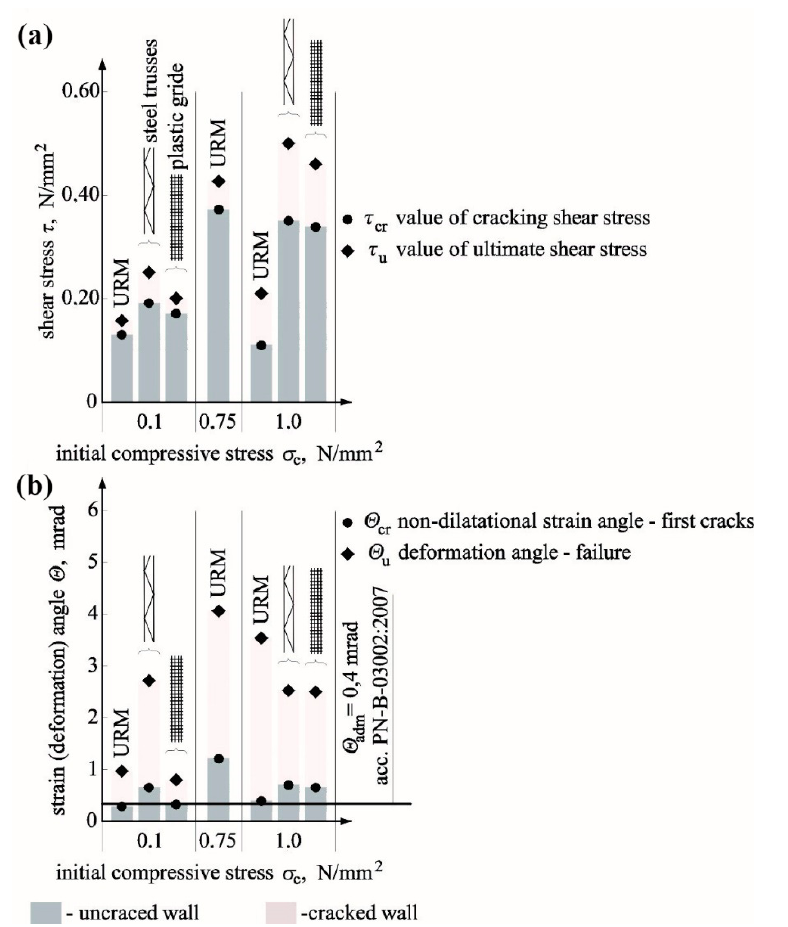
Figure 15. Comparison of test results: ( a ) shear stress at the time of cracking and failure and ( b ) shear–strain angle at the time of cracking and shear deformation angle at the time of failure.